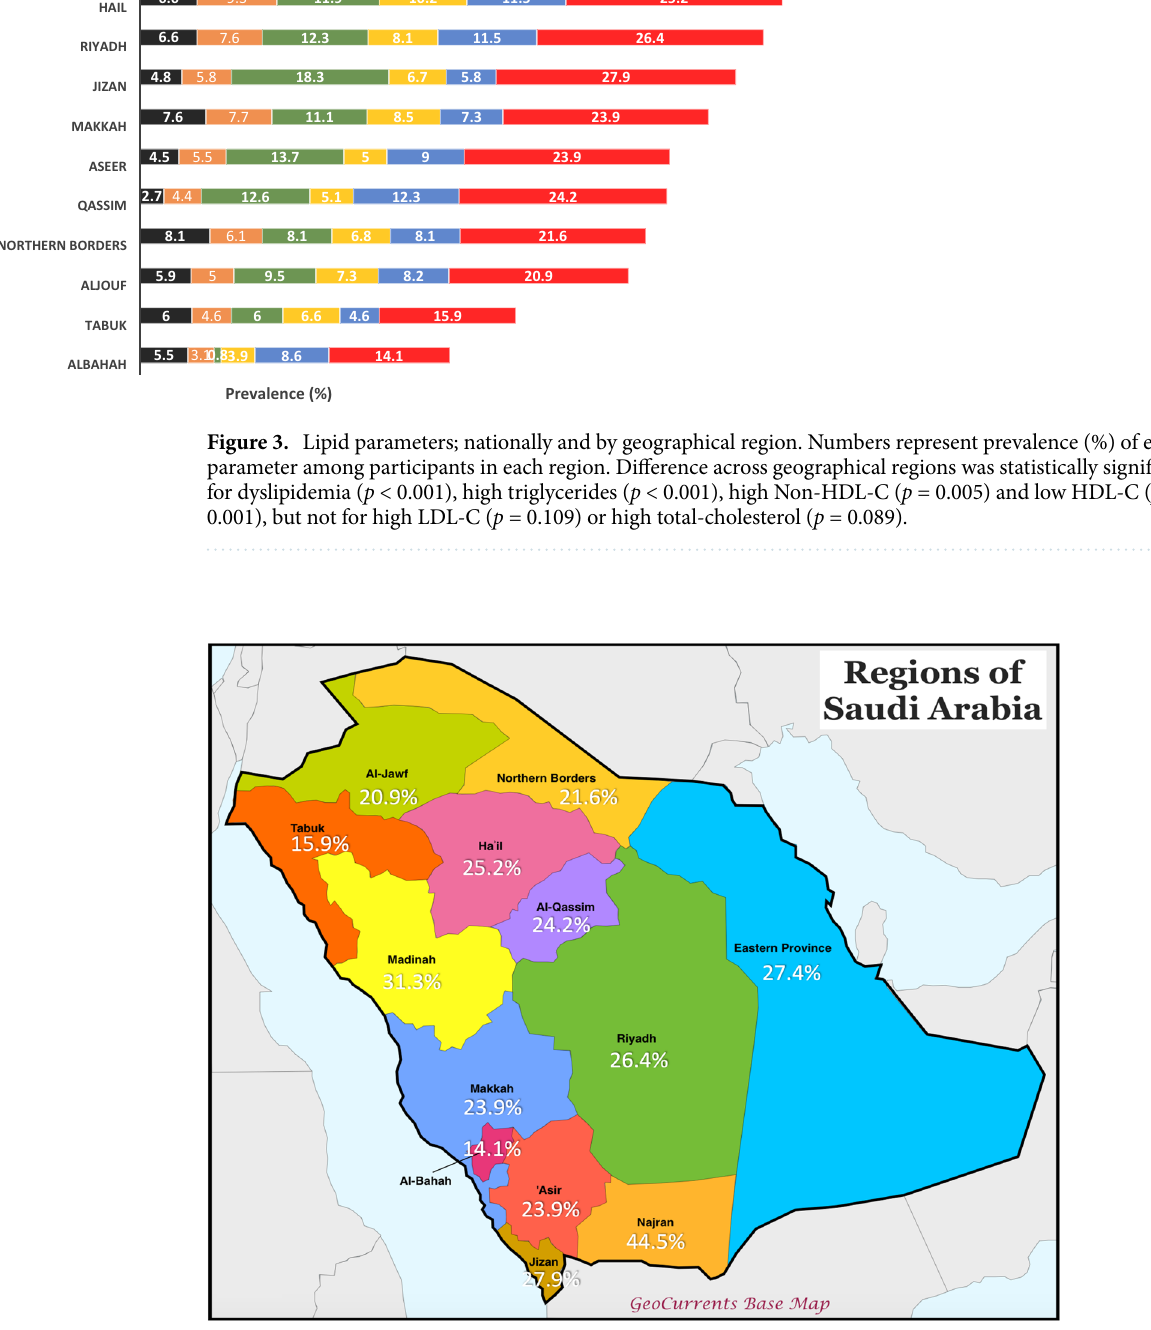
Figure 4. Prevalence rates of dyslipidemia in the 13 regions of Saudi Arabia. Modified from GeoCurrents Base Map. https:// www. geocu rrents. info/ custo mizab le- base-